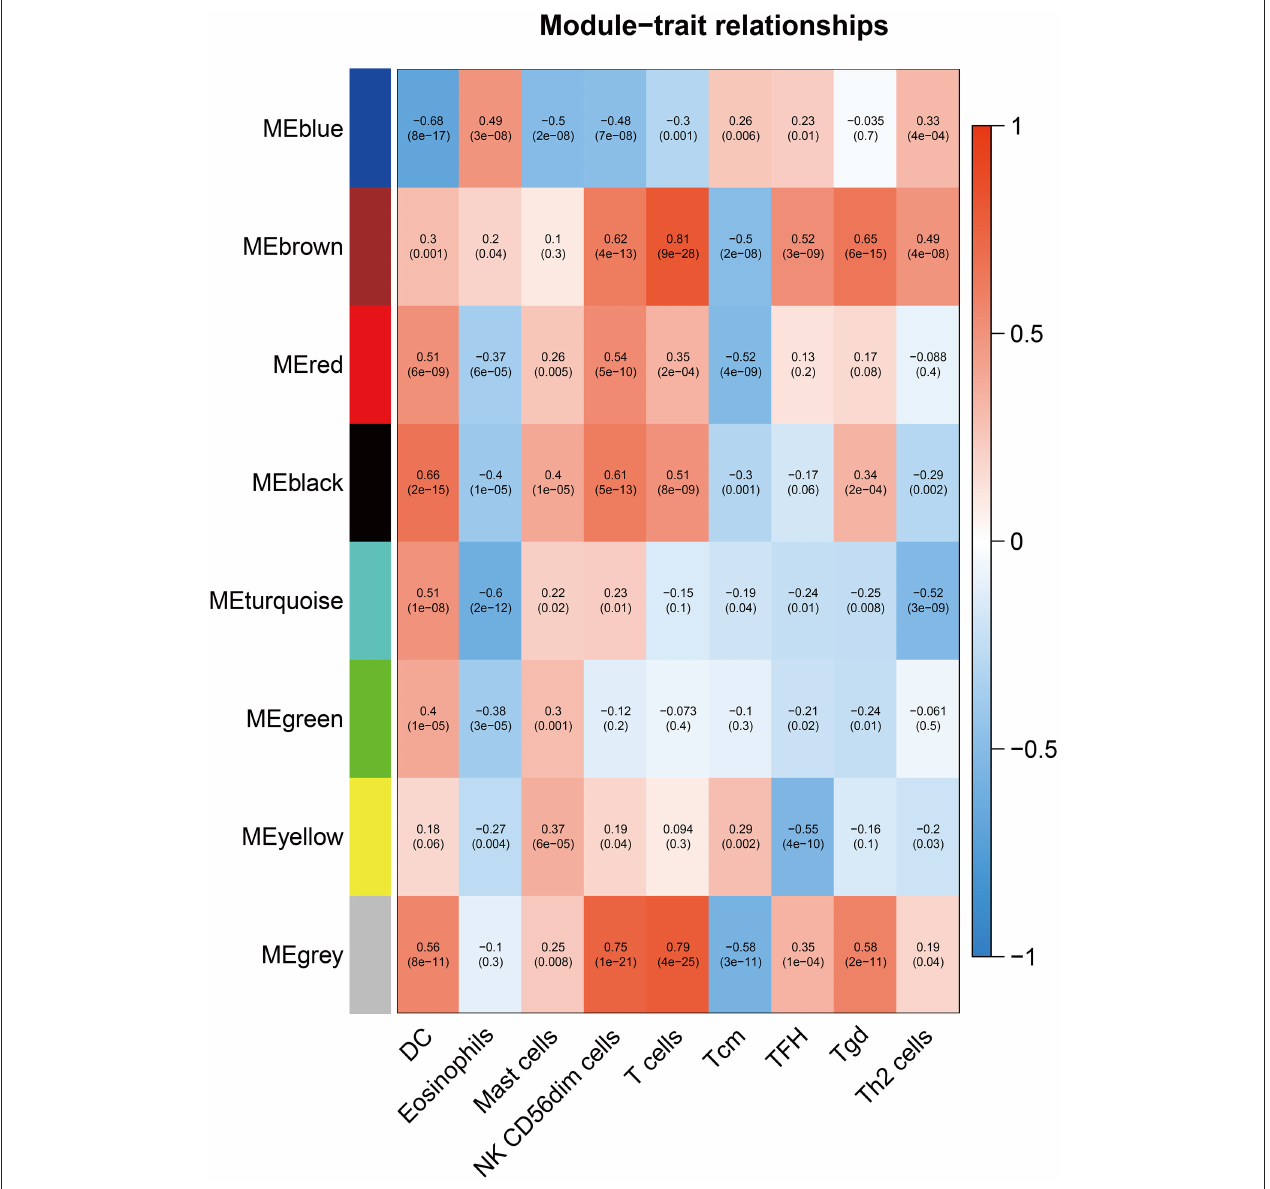
FIGURE 3 | Screening of the hub module associated with immune infiltration in CM. Heatmap of the correlation between module eigengene and differentially infiltrated immune cells. Each row represents a color-coded module eigengene, each column represents a type of infiltrated immune cells. The number in each cell means the correlation coefficient and p